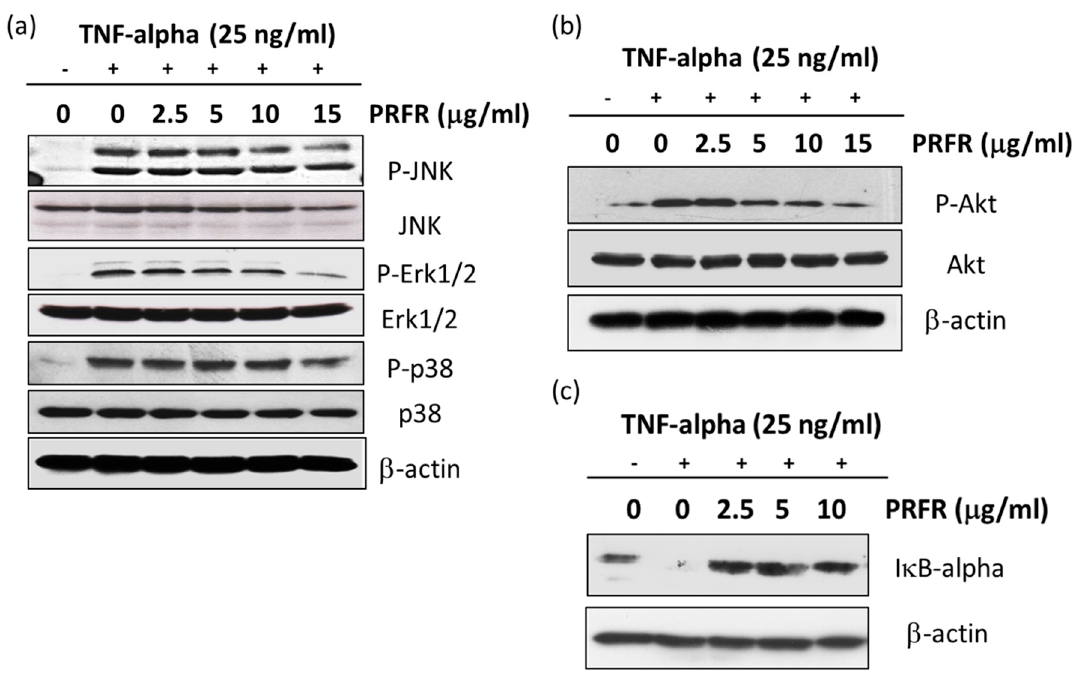
Figure 6. Effect of PRFR on TNF- α -induced MAPK, Akt, and I κ B- α signaling pathways. A549 cells were pretreated with PRFR and induced with TNF- α 25 ng/mL for 15 min. The whole cell lysate was prepared for measurement of phosphorylated and non-phosphorylated forms of JNK, Erk1/2, p-38 ( a ), and Akt ( b ) by western blot analysis. The whole cell lysate was also used to determine TNF- α -induced IkB- α degradation ( c ) by western blot analysis. Data from a typical experiment are presented here, while similar results were obtained from three independent experiments.